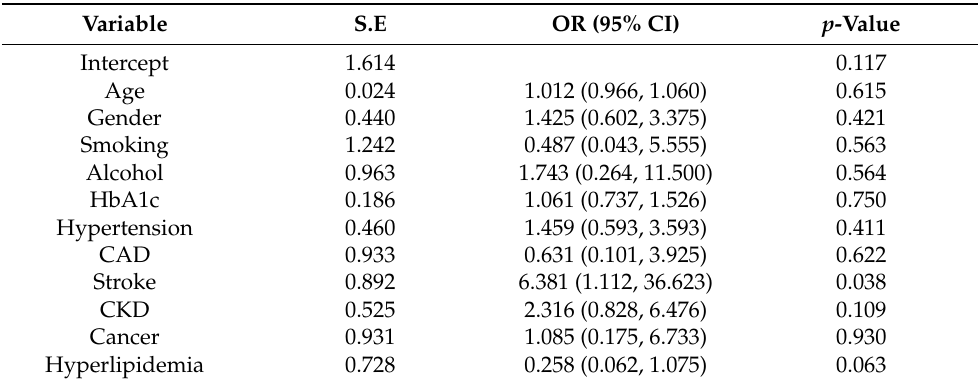
Table 3. Multivariate logistic regression analysis of morphological changes.